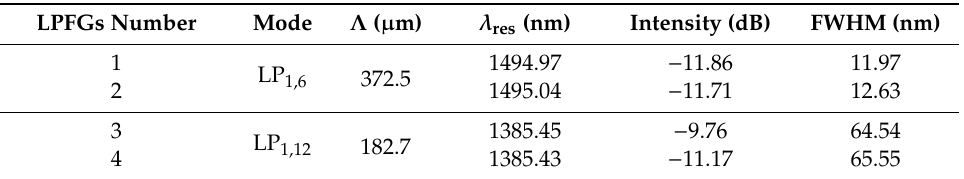
Table 1. Comparison between two pairs of LPFGs.